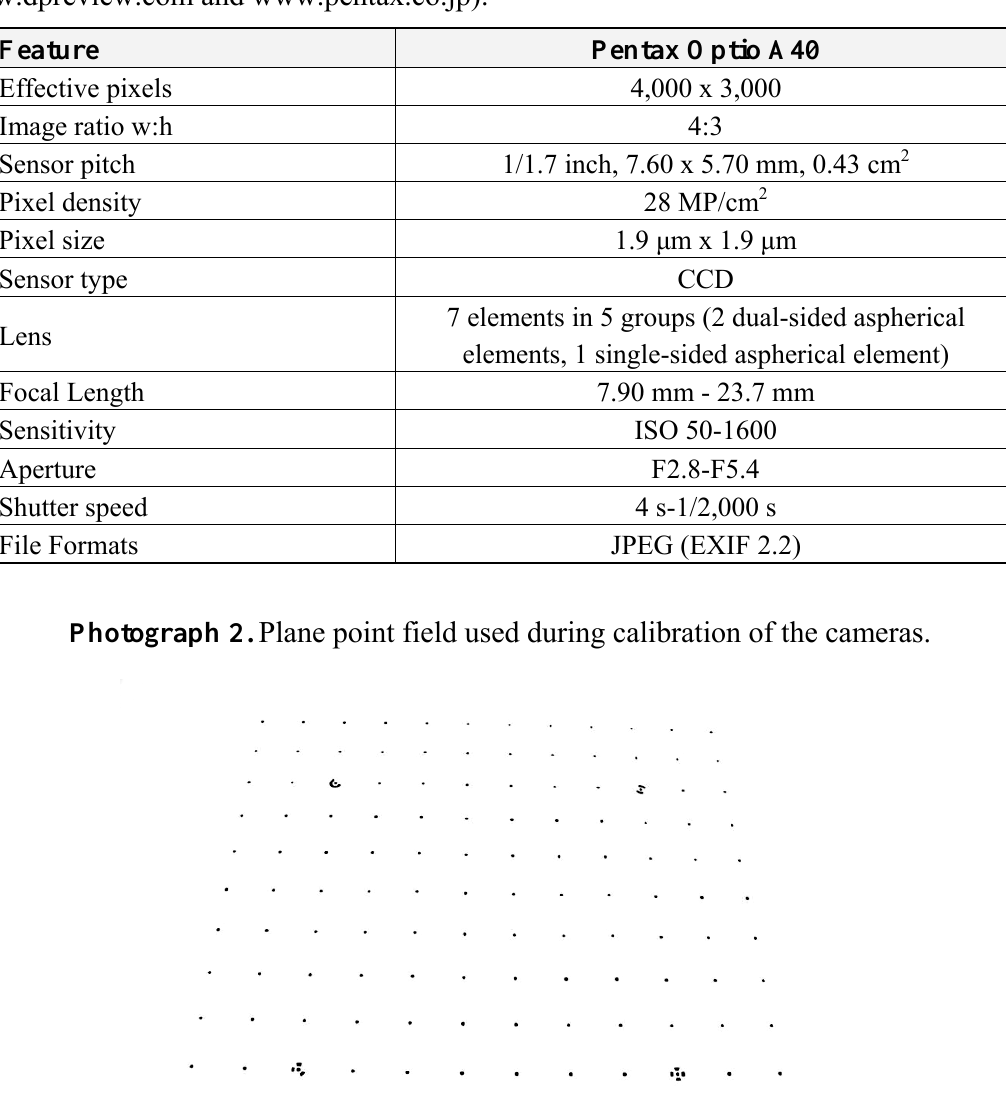
Table 1. Technical characteristics of cameras used in the measurement system (from www.dpreview.com and